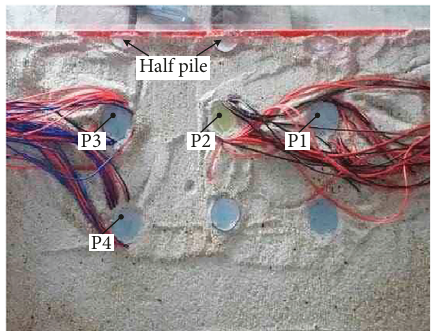
Figure 3: Sketch map of the piles.